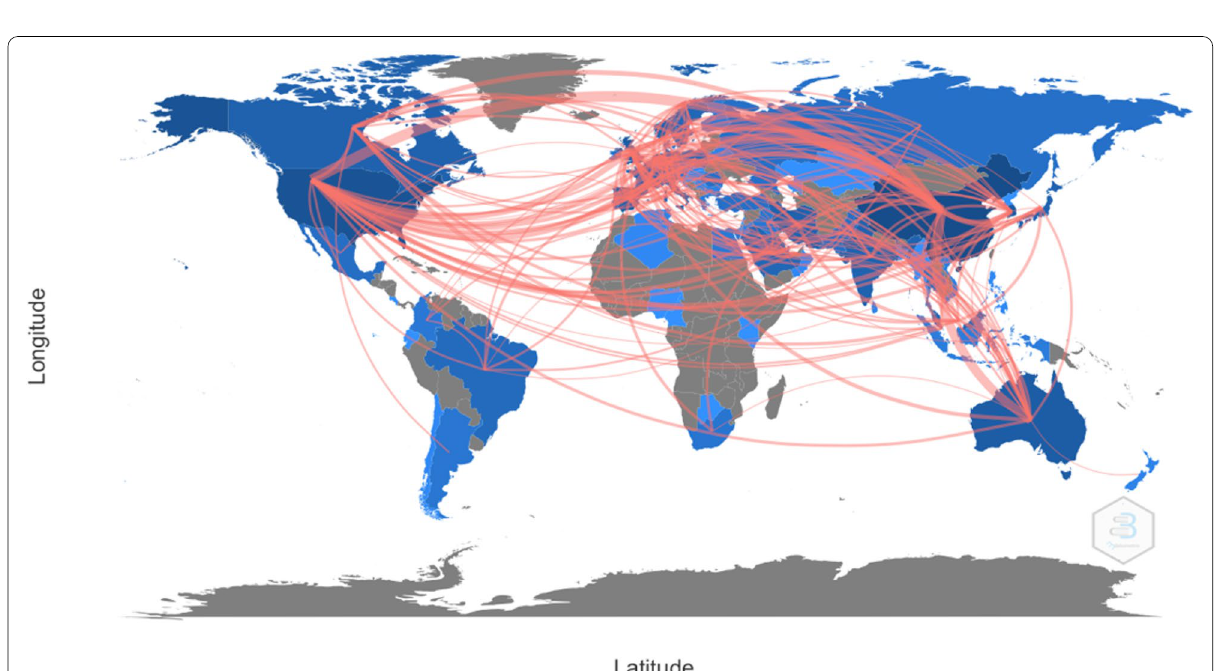
Fig. 38 Combined, country collaboration